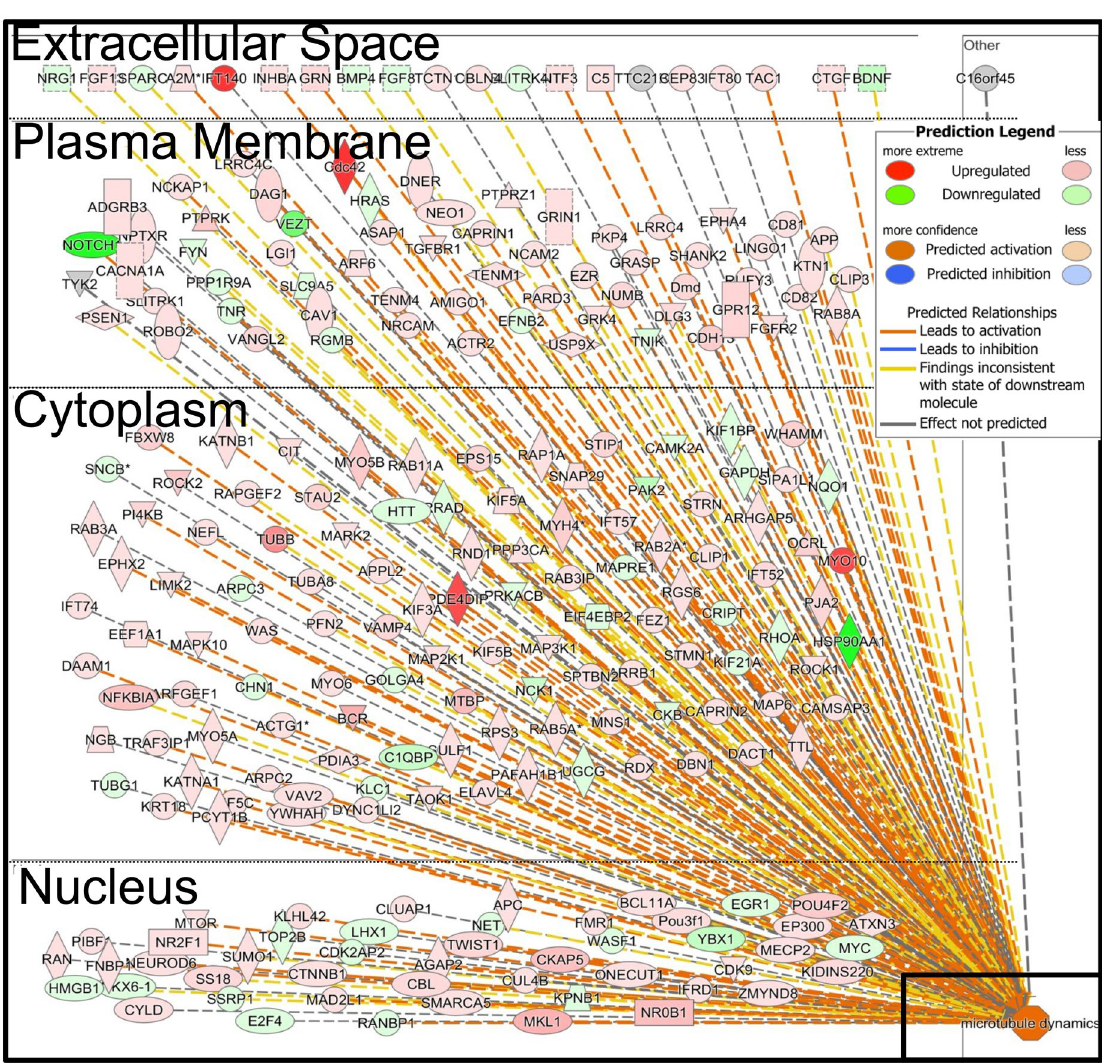
(https ://www.qiage nbioi nform atics .com/produ cts/ingen uityp athwa y-analy